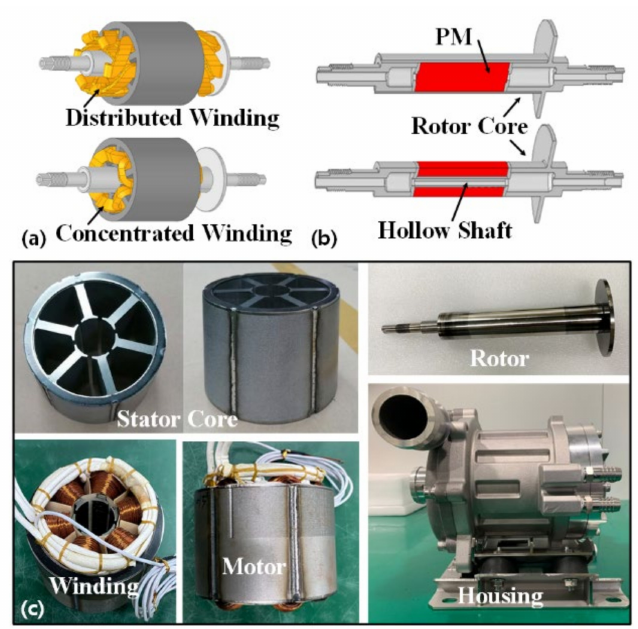
Figure 1. 3D structure of ( a ) two different winding patterns, ( b ) two different rotors, and ( c ) Manu- factured model of concentrated winding